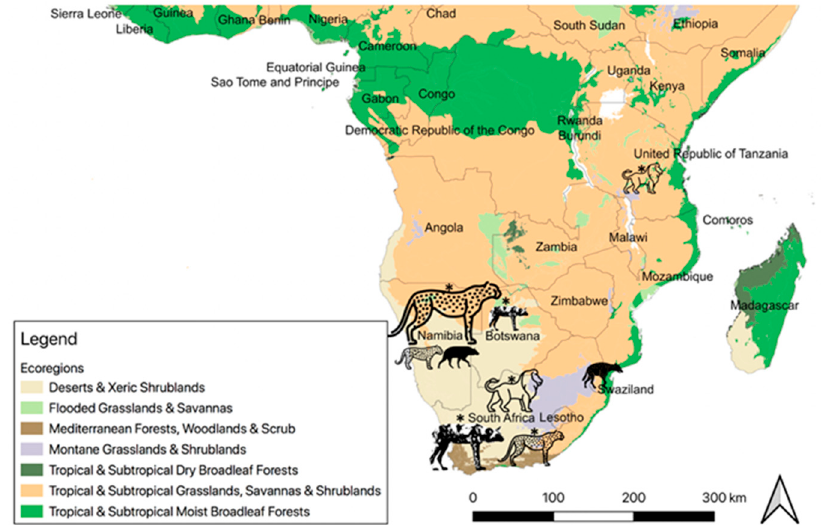
Figure 2. Distribution by country across Africa of publications relating to bush encroachment and large African carnivores that were identified in the review. Relative frequency of publications for each species indicated by size of icons; inclusion of paper(s) for species that assessed habitat variables without reference to bush encroachment indicated by an asterisk; cheetah, leopard, brown hyena, spotted hyena, lion, African wild dog. Data used to create map available in Table S1. Map generated in QGIS 3.10 (QGIS Association) [44]; map of Africa layer from ICPAC GeoPortal [45]; Ecoregion layer produced by Dinerstein et al. [46].